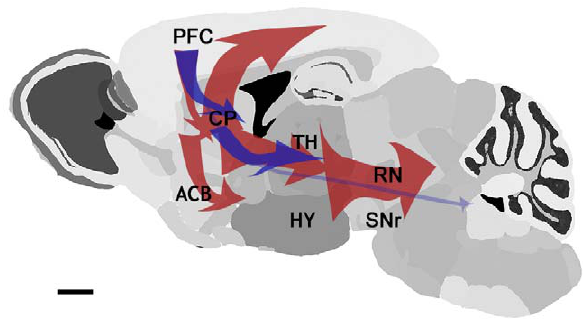
Figure 7. Schematic representation shows PFC associated circuits are more robust in WT compared to DAT KO mice. Major circuits delineated by MEMRI are shown. Red (WT) and blue (DAT KO) arrows in the schematic diagram indicate Mn 2 + transport in the two genotypes. Detailed anatomy and timing of Mn 2 + transport are shown in Table